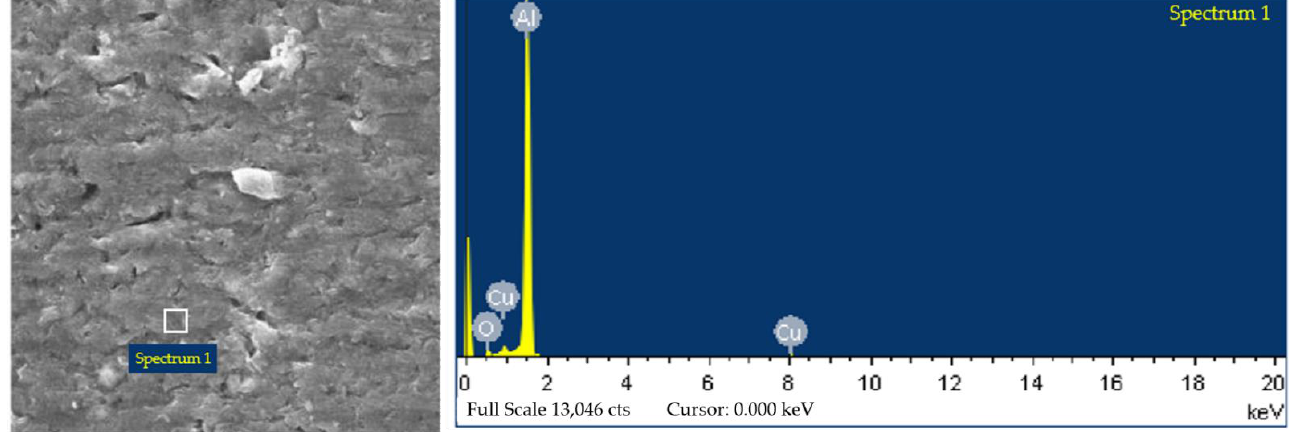
Figure 11. The EDS of precipitation particles of Al-0.5%Cu alloy in SH annealing at 250 °C for 10 min. Liu, W. C. et al. [28] used two annealing processes to study the influence of different heating rates on the recrystallization behavior of AA3015 aluminum alloy. They found that P texture and Cube- ND texture were formed by SH treatment, while finer equiaxed grains and less Cube recrystallization textures were formed in RH. They interpreted this phenomenon as diffusion accompanied by precipitation during the annealing process and affected the grain size and texture type of the recrystallization structure. Wang, X. et al.